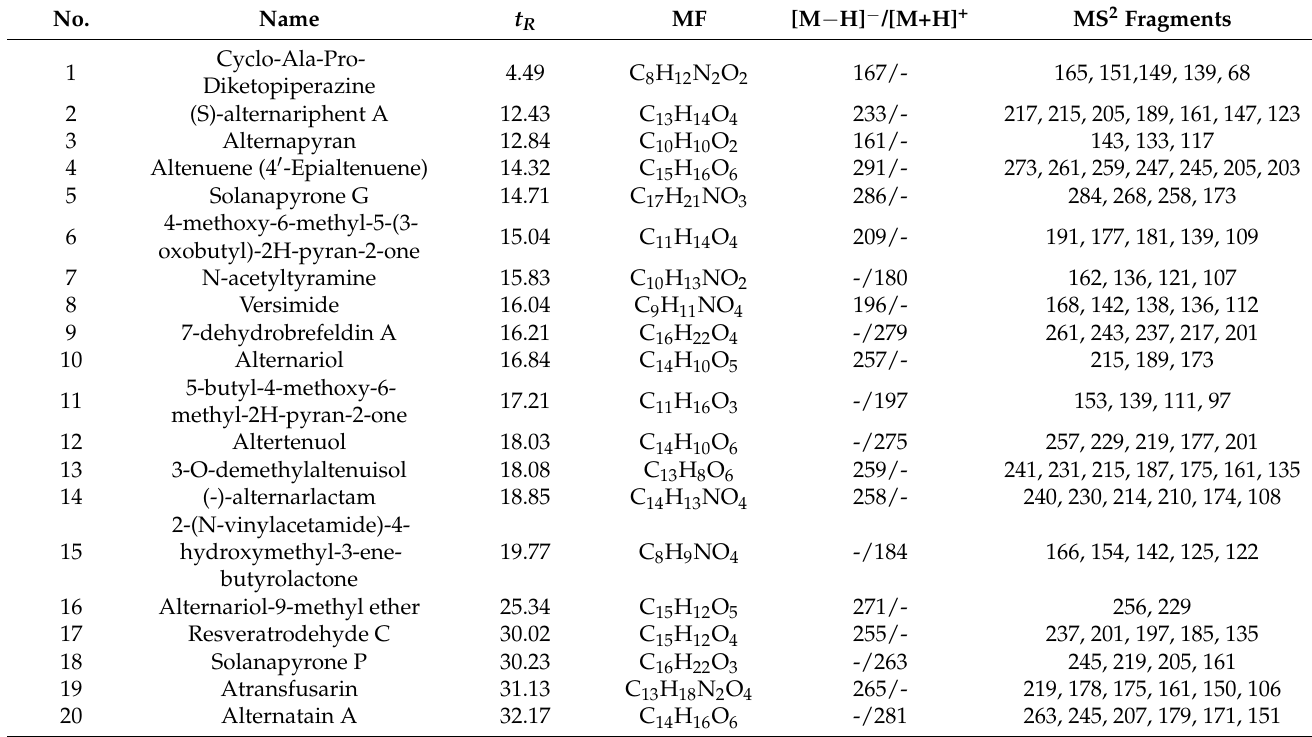
Table 4. List of tentatively identified compounds in A. tenuissima extract.